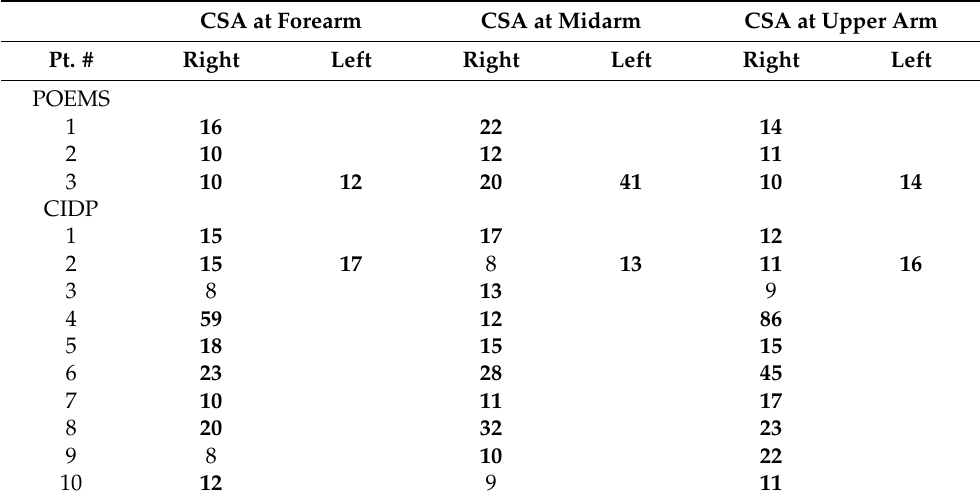
Table 5. HRUS findings in upper limb nerves: ulnar nerve CSA values in mm 2 . CSA at Forearm CSA at Midarm